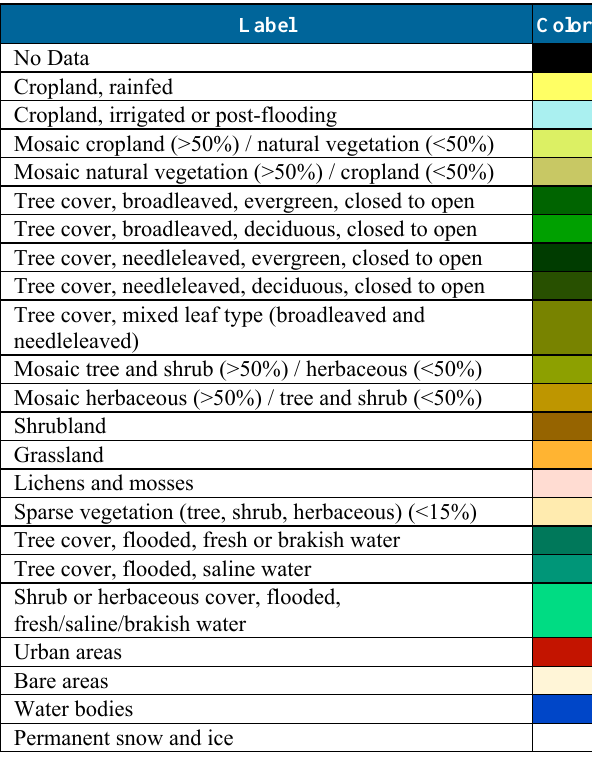
Table 1. Legend of the global LC maps, based on